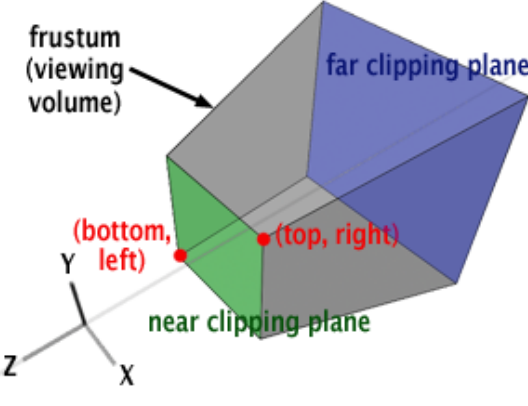
Figure 3. Principle of Perspective Projection (Scratchapixel, 2014)